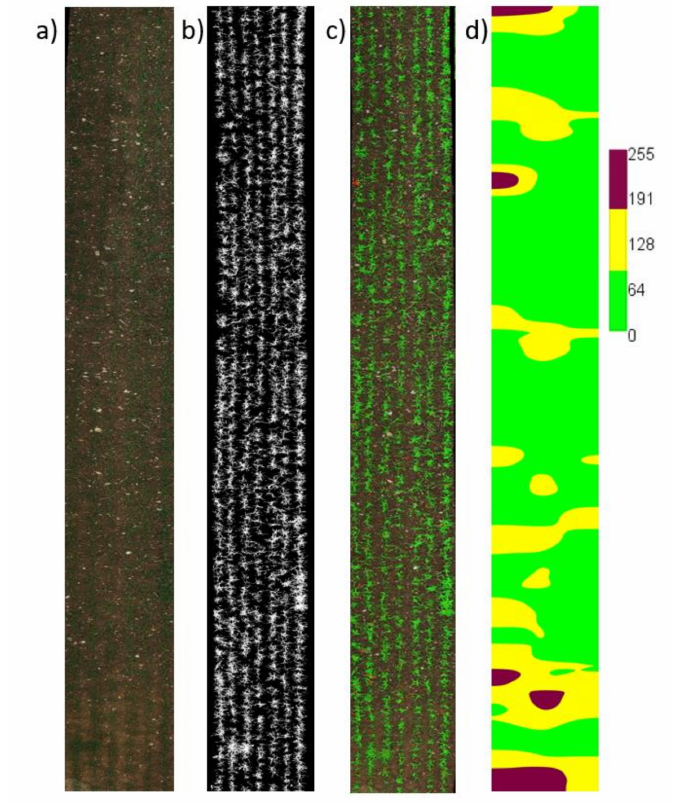
Figure 4. Four output maps on date 1: ( a ) Global RGB image of the field deduced from 254 images manually acquired; ( b ) Vegetation Image deduced from the MetaIndex; ( c ) Crop / weed discrimination using a SVM classifier (green = wheat, red = weed); ( d ) Weed pressure